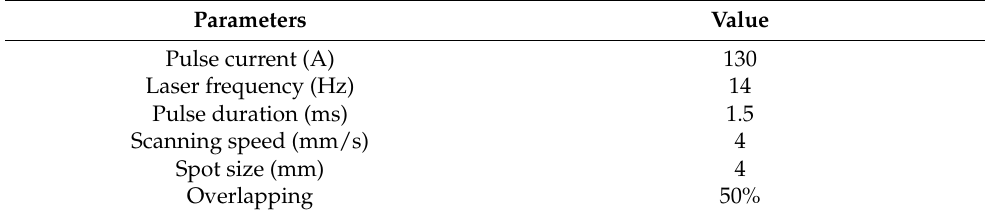
Table 3. Parameters of laser